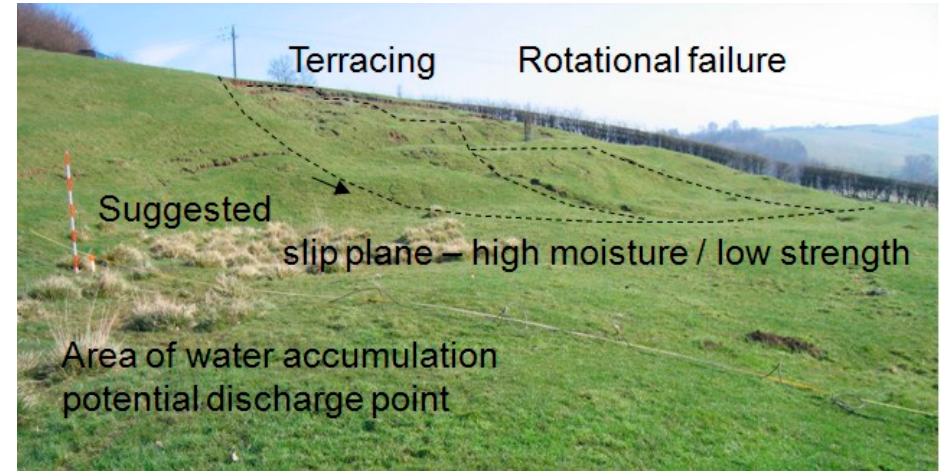
Remote Sens. 2021 , 13 , x FOR PEER REVIEW Figure 13. Annotated photograph of the Hollin Hill landslide. Figure 13. Annotated photograph of the Hollin Hill landslide.